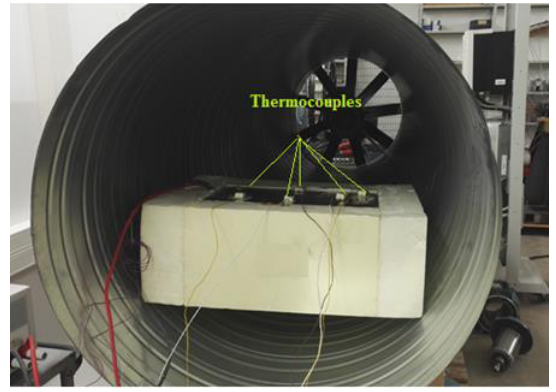
Fig. 5. Coil box inside the wind tunnel and location of the